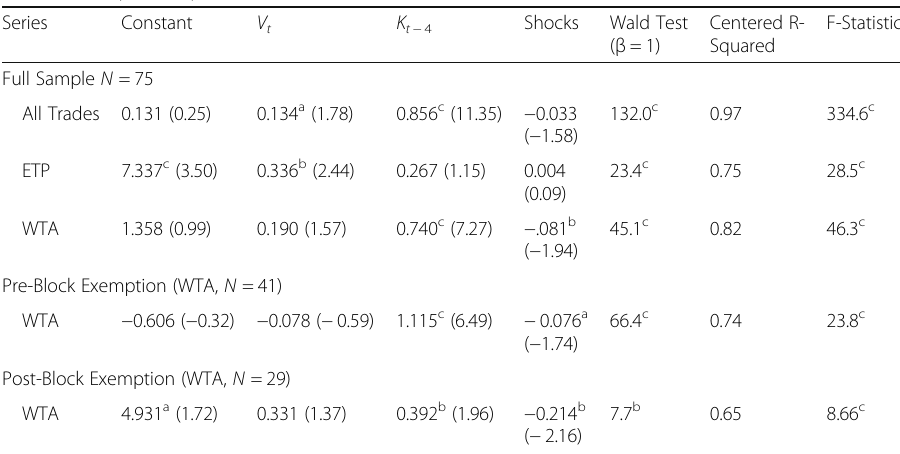
Table 4 Adaptive expectations – GMM